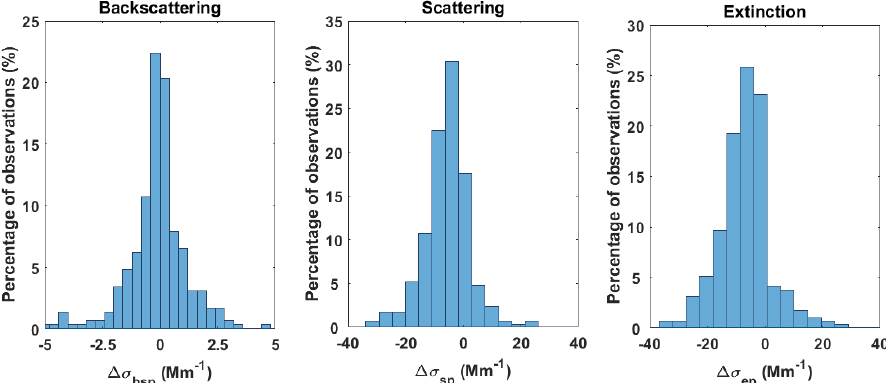
Figure 2. Histograms of the absolute difference between in situ-measured and retrieved with GRASP pac optical parameters (aerosol backscat- tering, scattering and extinction coefficients) at low ambient RH (RH ambient < 50%).